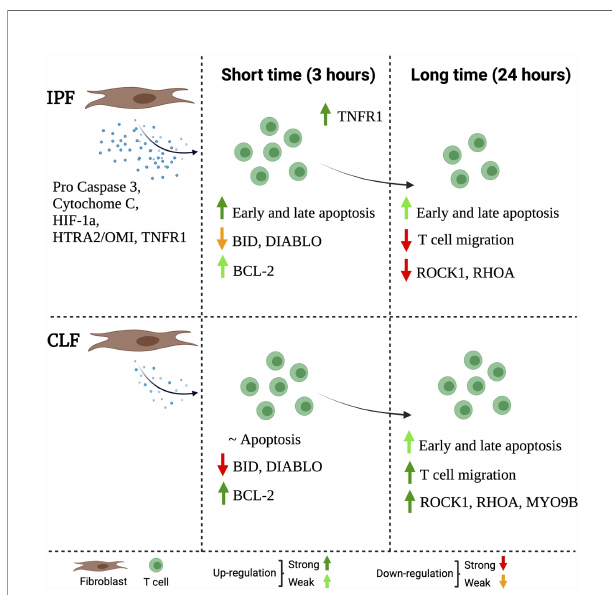
FIGURE 8 | Schematic representation of the proposed mechanism through IPF fi broblasts affects the function of T cells. The IPF fi broblast secretes high levels of pro-apoptotic molecules (left). This microenvironment, at a short time (3 h) of exposure, activates T-cell death, but at the same time, the T cells activate a weak anti-apoptotic pro fi le as a defense mechanism. This pro fi le is characterized by a slight loss of BID and DIABLO as well as a discrete presence of the Bcl-2; moreover, they increase TNFR1 expression (mild). At a long time of exposure (24 h), surviving T cells have decreased the expression of MYO9B, ROCK1, and RHOA, and consequently, these T cells are unable to migrate (right). The fi gure was created in